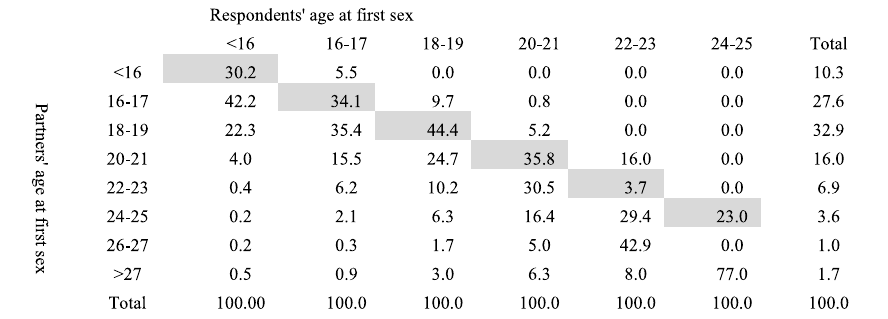
partners, 2017 SELFY